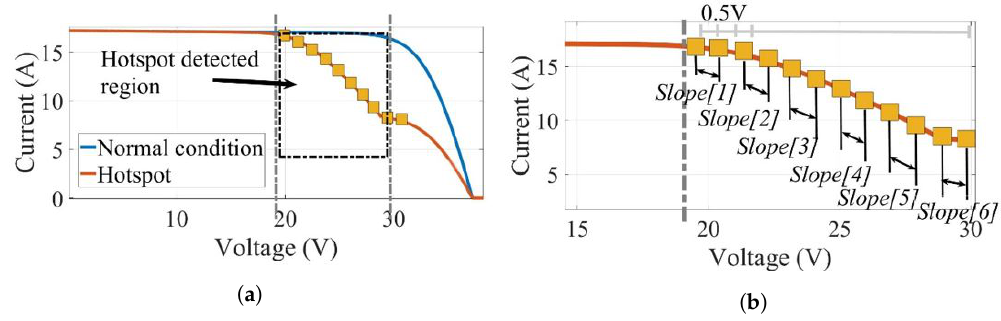
Figure 11. Example I–V characteristic curve for hotspot detection algorithm: ( a ) full I–V curve; ( b ) magnified reverse bias